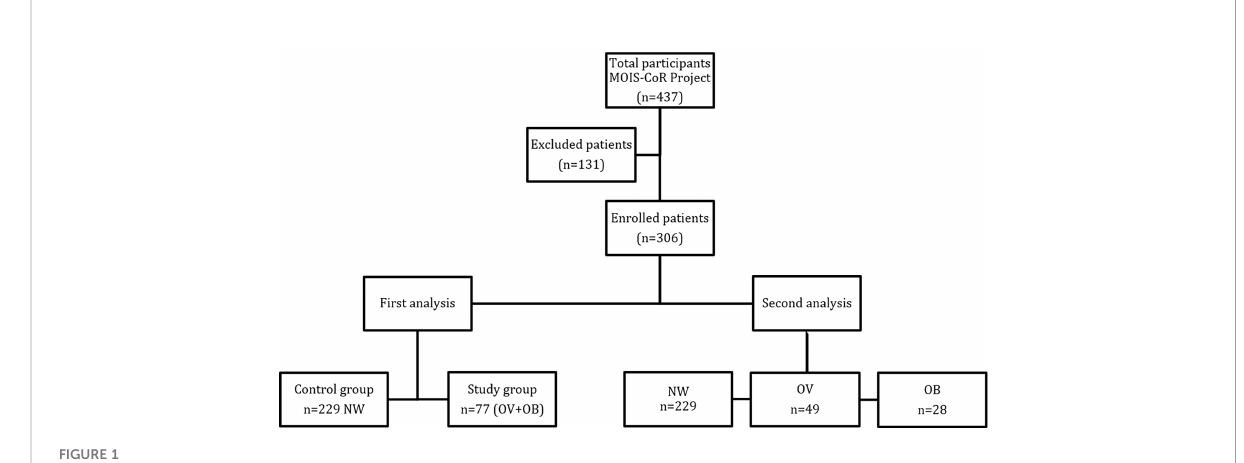
FIGURE 1 Flowchart of patients included in the MOIS-CoR study.